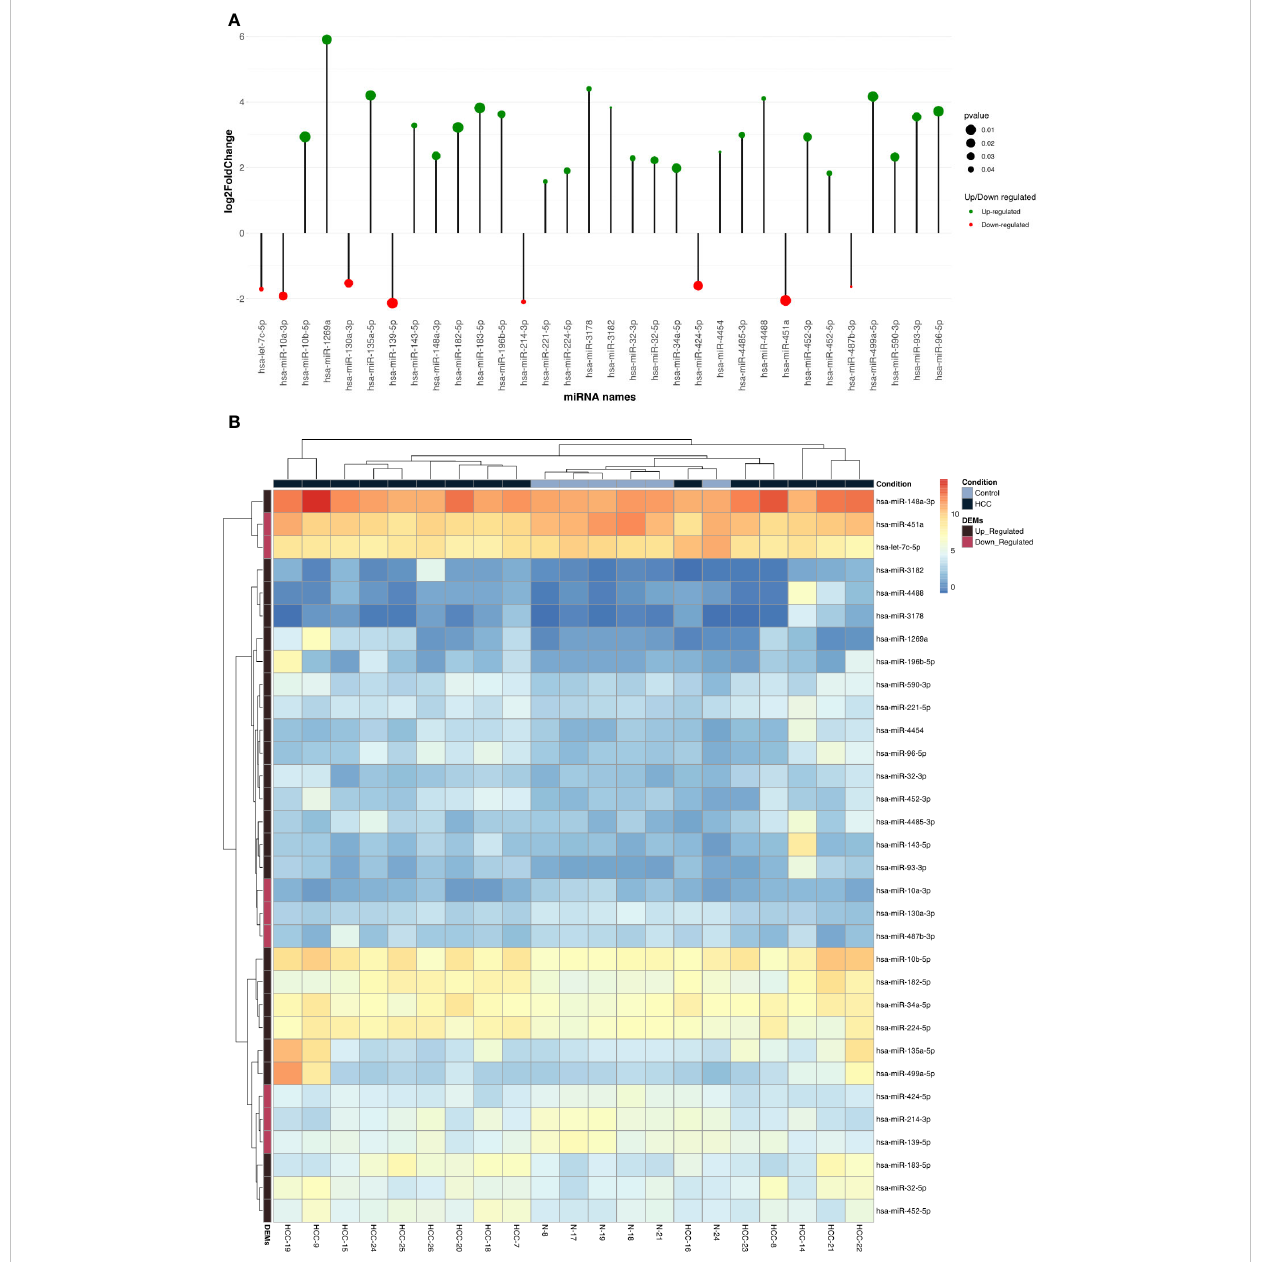
FIGURE 3 (A) Lolliplote represent up and down differentially expressed miRNAs based on log2fold change and P value , it showed 23 up regulated with 8 down regulated DEMs. Green circles for up regulated DEMs and Red circles for down regulated DEMs. The circle size re fl ects P value . (B) The fi gure represents heat maps of differentially expressed miRNAs in HCC tissue and tumor adjacent tissue as control (HCC for HCC patient tissues samples and N for tumor adjacent cirrhotic tissue samples) the key representing HCC samples with up or down DEMs. Black square upper the heat maps represent HCC samples and the blue one represent tumor adjacent tissue samples. The black square left the map represent up regulated DEMs and purple one for down regulated